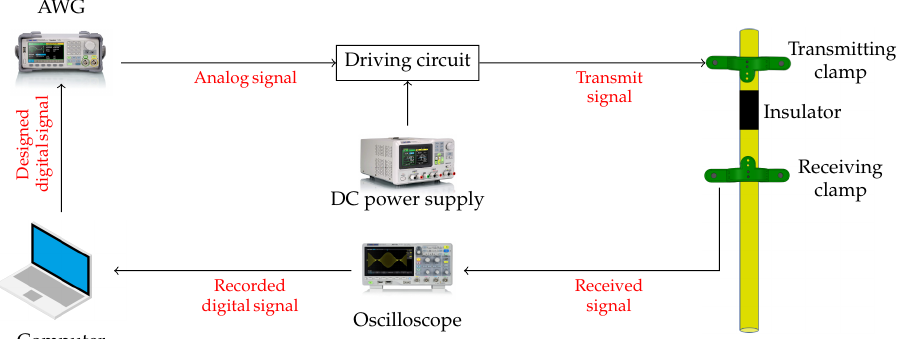
Figure 2. Clamp Design: The clamp has a total of eight slots, six of which form a ring where transducers can be placed 60 degrees apart, and two additional slots which are 180 degrees apart for deploying additional transducers. This clamp was modified from the original design in [34].